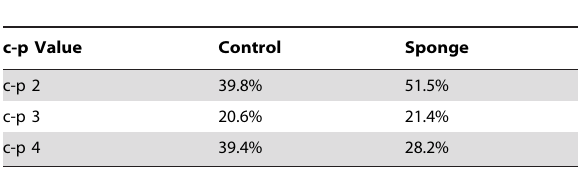
Table 6. Percentage of nematodes in life history categories (c-p values) in control and sponge samples (0–1 cm sediment